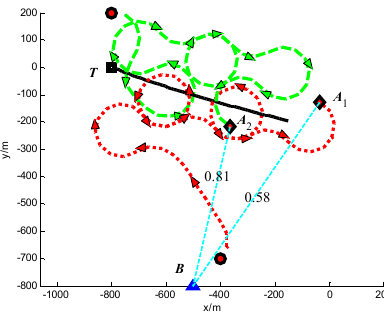
Figure 12. Trajectories of UAVs and target at t = 30 s (Group B in Scenario 1).